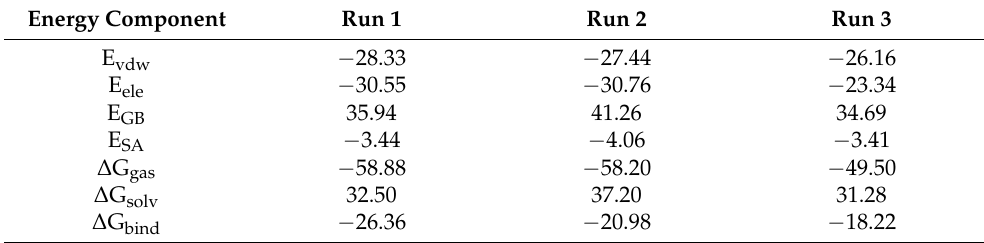
Table 4. Binding free energy (kcal mol − 1 ) of the complexes obtained during the last 5 ns of MD simulations for all three